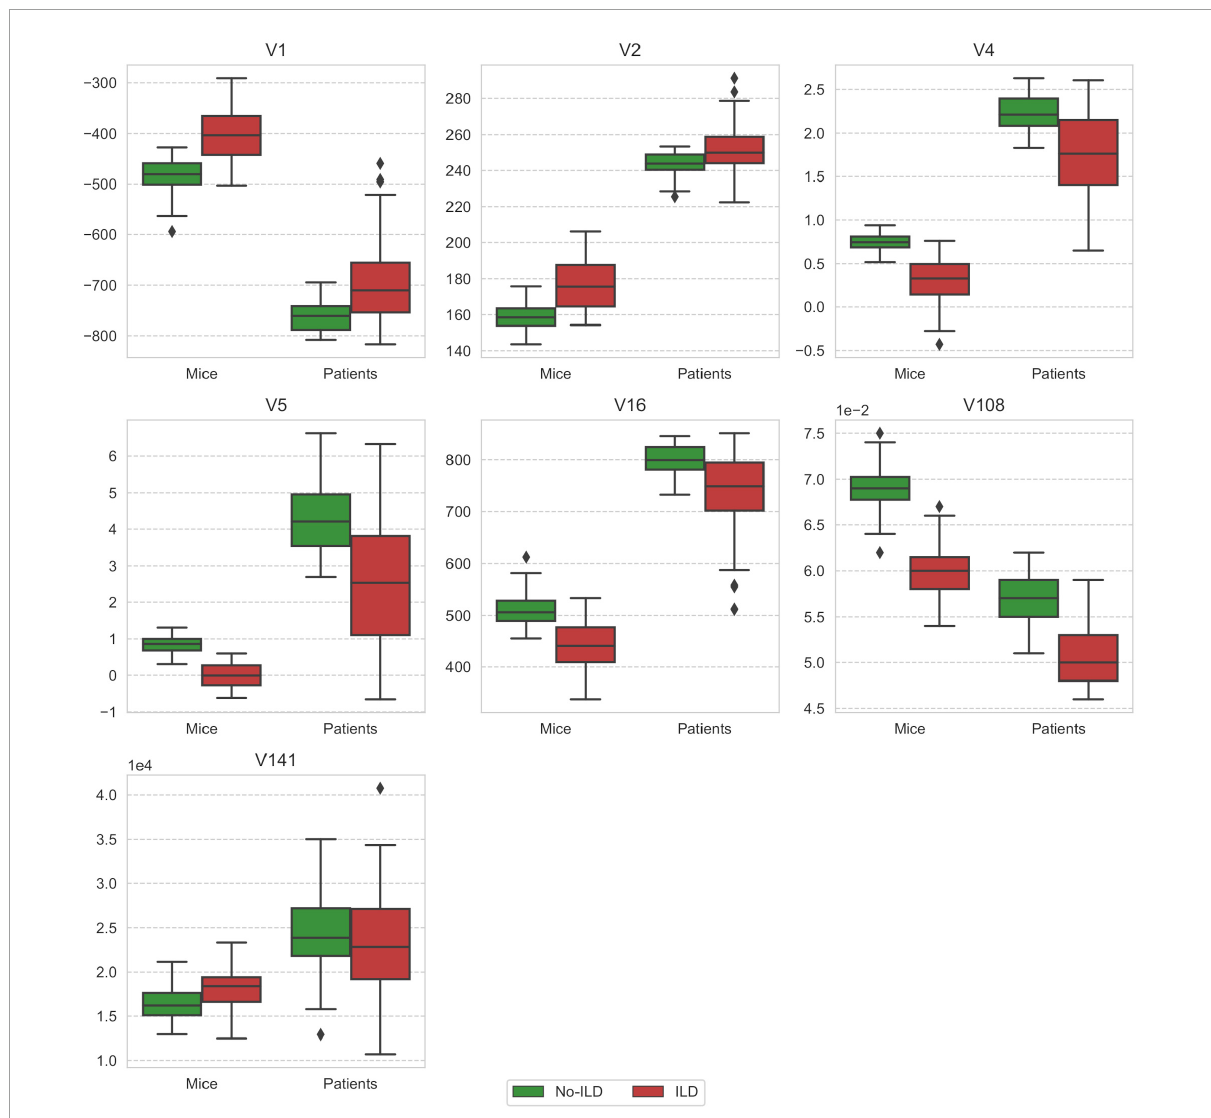
FIGURE6 Comparison of feature distribution between mice and patient groups stratified by the ILD stage. V1 - mean ( histogram), V2 - standard deviation (histogram), V4 - skewness (histogram), V5 - kurtosis (histogram), V16 - root mean square (histogram), V108 - gray level non-uniformity normalized (GLSZM), V141 - dependence count non-uniformity